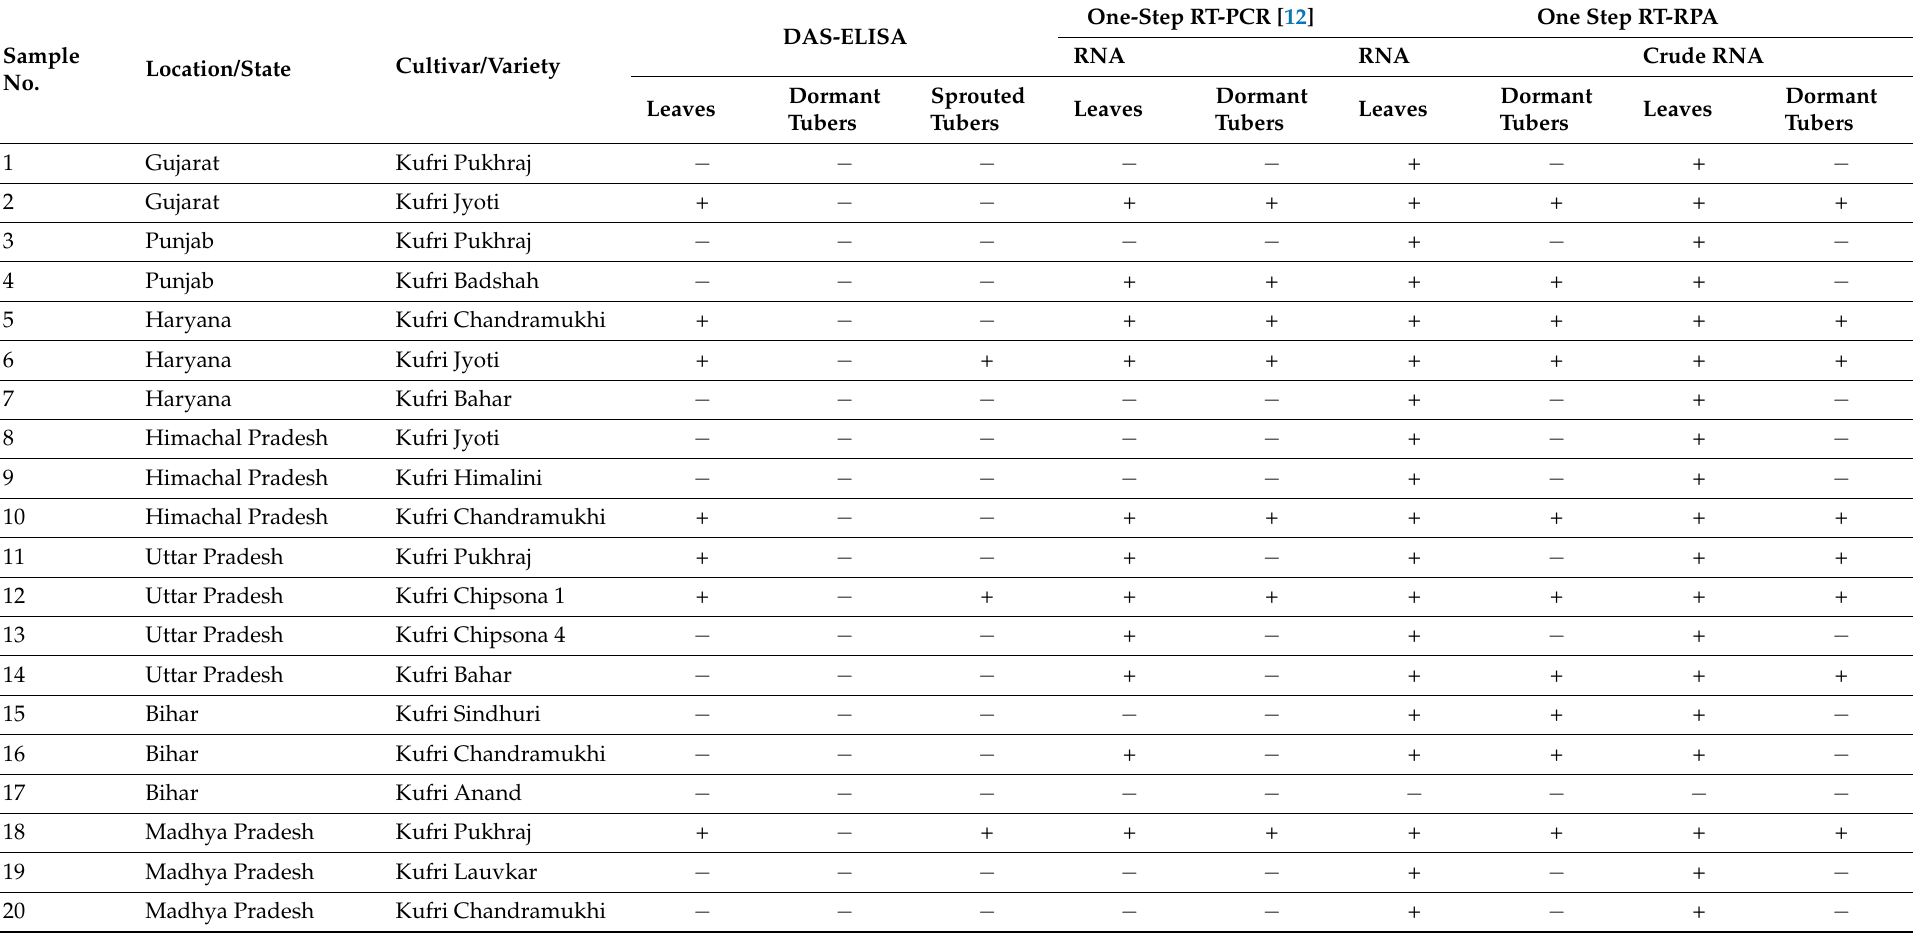
Table 3. Comparative performance of double antibody sandwich enzyme-linked immunosorbent assay (DAS-ELISA), reverse transcription-polymerase